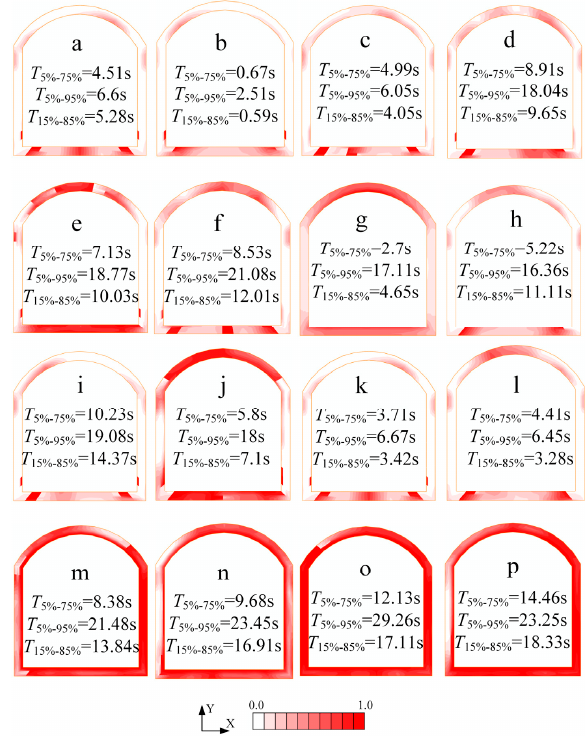
Figure 8. The accumulated damage crack patterns of the concrete lining under the different duration of NFGMs. ( a ) San Fernando, ( b ) Coyote Lake, ( c ) Imperial Valley-06 (Aeropuerto Mexicali), ( d ) Imperial Valley-06 (Brawley Airport), ( e ) Imperial Valley-06 (El Centro Array #11), ( f ) Imperial Valley-06 (El Centro Array #3), ( g ) Imperial Valley-06 (El Centro Differential Array), ( h ) Mendocino, ( i ) Landers (Barstow), ( j ) Landers (Yermo Fire Station), ( k ) Northridge-01, ( l ) Kocaeli, ( m ) Chi-Chi (TCU053), ( n ) Chi-Chi (TCU054), ( o ) Chi-Chi (TCU056), ( p ) Chi-Chi (TCU060)